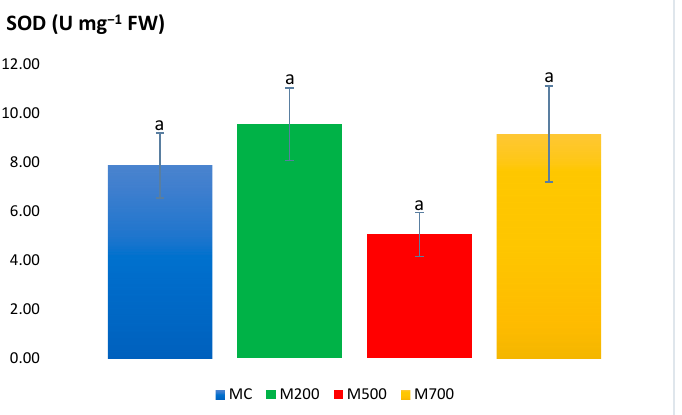
Figure 2. Superoxide dismutase (SOD) activity in the leaves of Mis-B cultivar cultivated in soils with gradient T.E. concentrations (MC, M200, M500, M700). Values are presented as mean ± SE. Di ff erent le tt ers refer to signi fi cant di ff erences between plants (Tukey HSD test, n = 6, p ≤ 0.05).